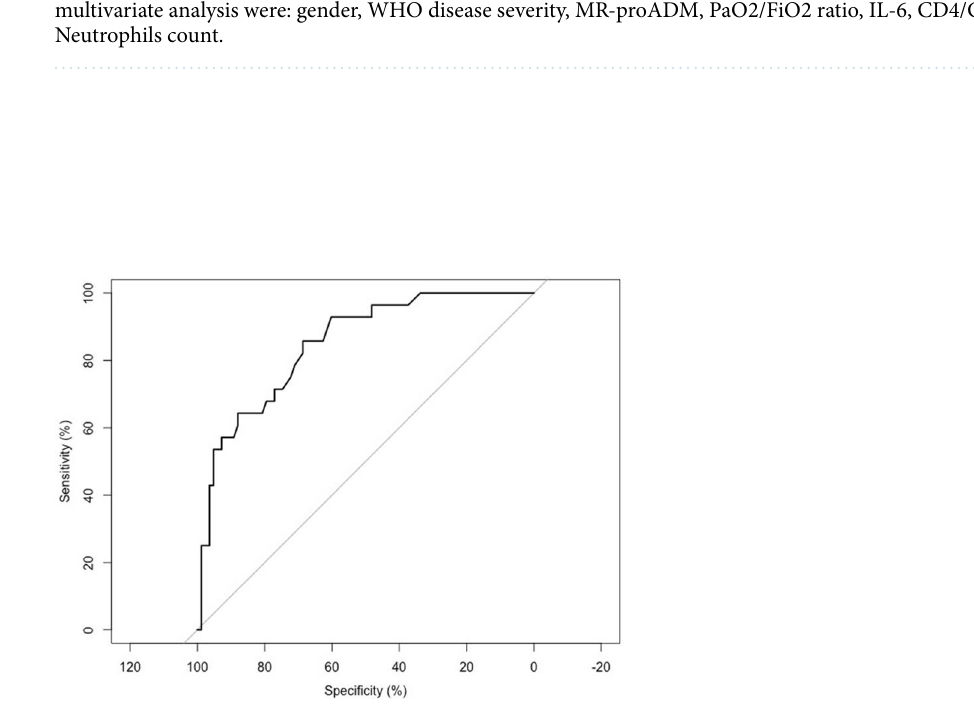
Figure 1. AUROC analysis: MR-proADM on combined event of death or orotracheal intubation (IOT). AUROC: 0.849 [0.771–0.730], p < 0.0001. Optimal cut-off value of MR-proADM: 0.895; a sensitivity of 0.857 [0.728–0.987] and a specificity of 0.687 [0.587–0.787] correspond to this cutoff